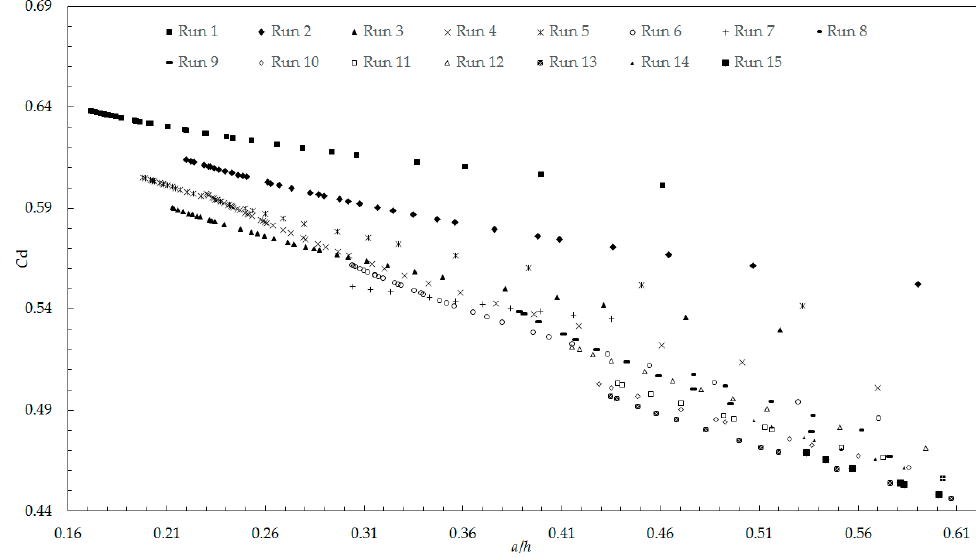
ffi cients ( C / h , Series d ) versus a